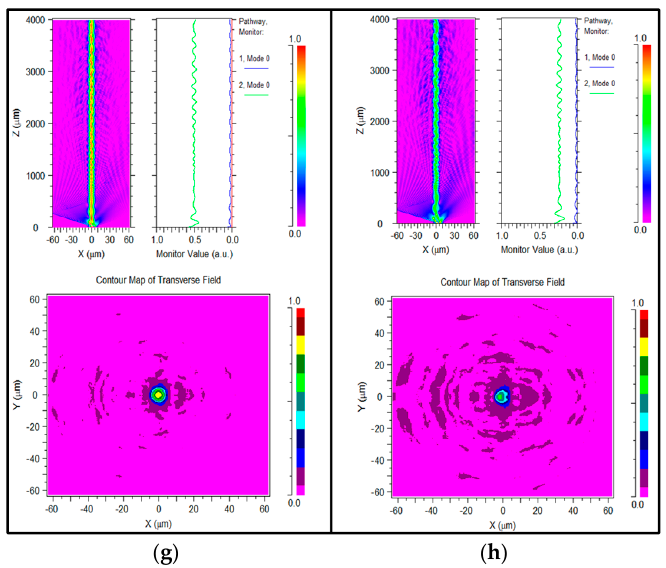
Figure 6. The distribution of optical field with 8° fiber moving up along X/Y-axis. ( a ) is the optical fiber offset 4 um along the negative X-axis, namely the coordinate ( − 0.004,0,0); ( b ) is the optical fiber offset 4 um along the negative X-axis, namely the coordinate ( − 0.002,0,0); ( c ) is the optical fiber offset 2 um along the positive X-axis, that is, the coordinate (0.002,0,0); ( d ) is the optical fiber offset 4 um along the positive X-axis, namely the coordinate (0.004,0,0); ( e ) is the optical fiber offset 4 um along the negative Y-axis, that is, the coordinate (0, − 0.004,0); ( f ) is the optical fiber offset 2 um along the negative Y-axis, that is, the coordinate (0, − 0.002,0); ( g ) is the optical fiber offset 2 um along the pos- itive Y-axis, that is, the coordinate (0,0.002,0); ( h ) is the optical fiber’s positive Y-axis deviation of 4 um, that is, the coordinate (0,0.004,0).